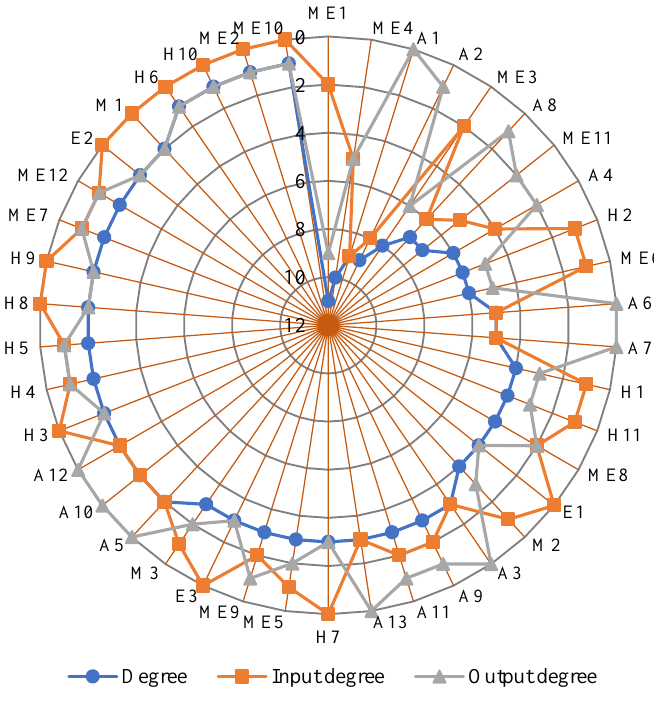
Figure 5. Degree distribution. Table 5. The average degrees of various types of vertex